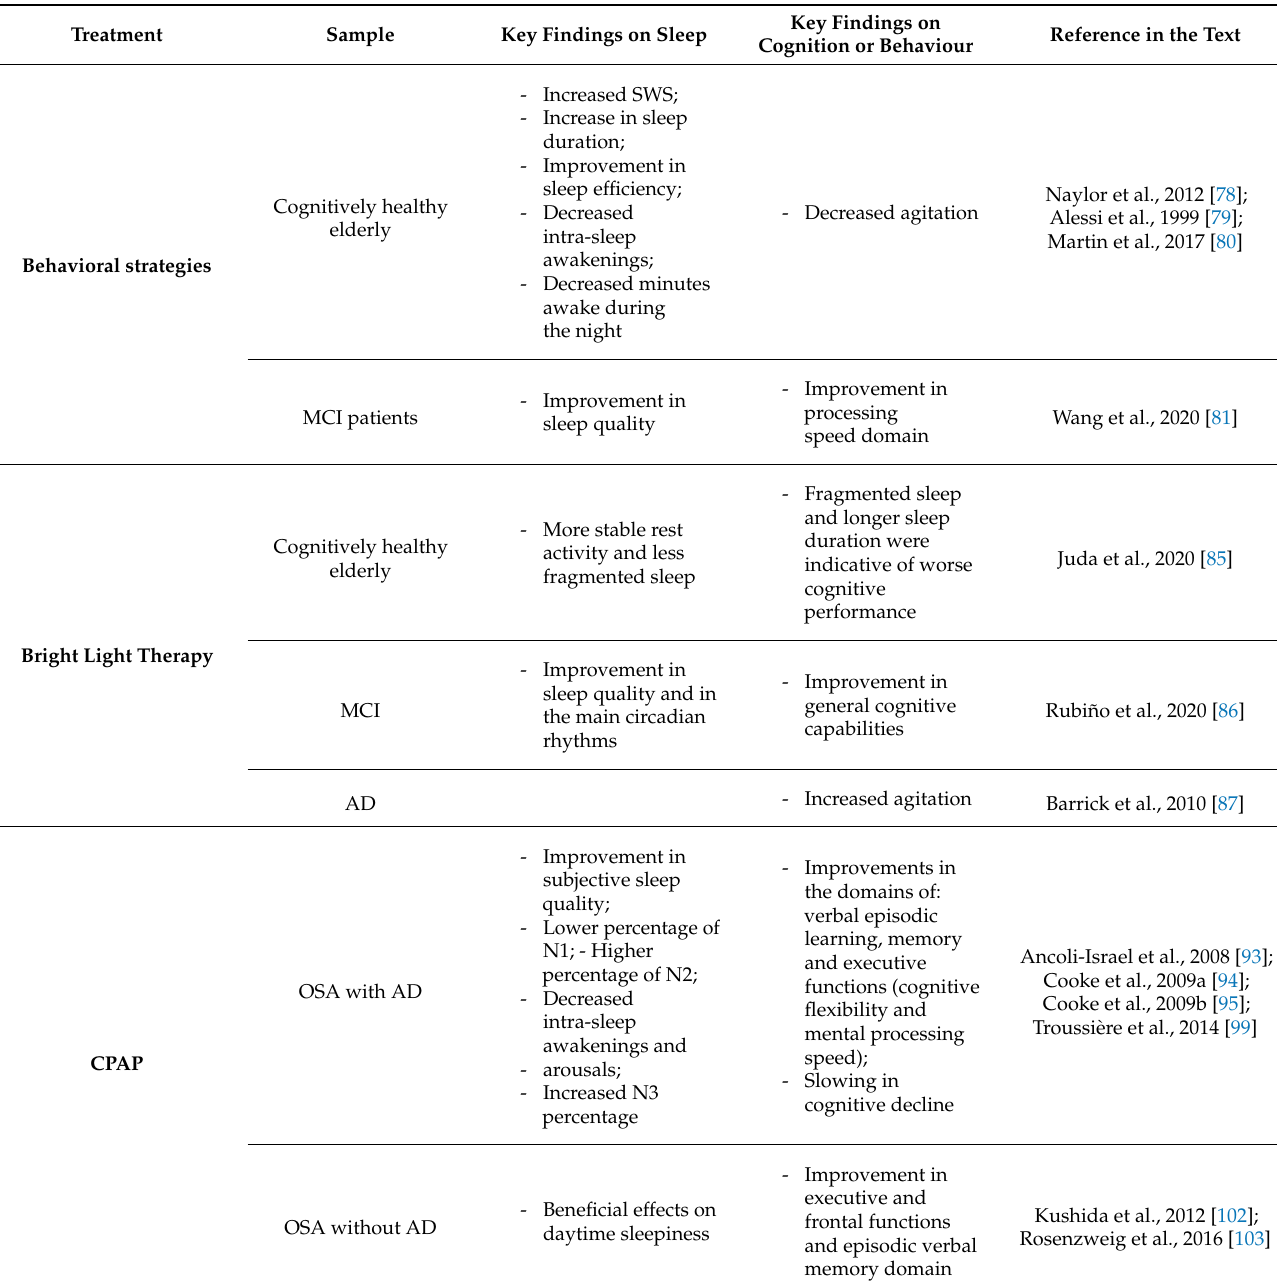
Table 1. Summary of the main effects of different treatments (i.e., behavioral strategies, bright light therapy, CPAP) on sleep, cognition and behaviour reported in the studies included in this